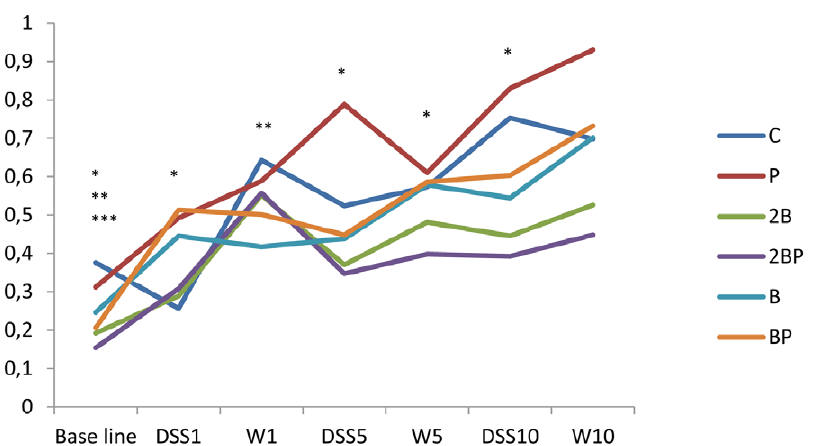
Figure 2. Concentrations of haptoglobin. Haptoglobin concentrations (mg/ml) in blood during the 11 cycles of DSS administration. Concentrations are expressed as medians (25 and 75 percentiles). Significant differences are expressed versus the C group. Base line: *P , 0.05 for group B, **P # 0.01 for group 2B group, ***P , 0.001 for group 2BP. DSS cycle 1: *P , 0.05 for group BP. DSS cycle 5: *P , 0.05 for group 2B. DSS cycle 10: *P , 0.05 for group 2B. Pure water cycle (W1): **P , 0.01 for group B; Water cycle 5 (W5) *P , 0.05 for group 2B group.